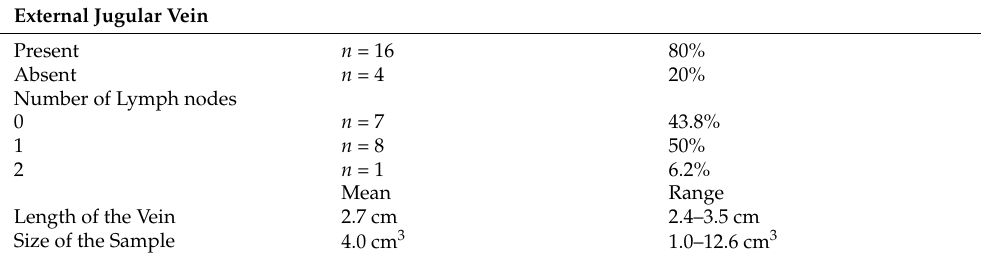
Table 2. Evaluation of specimens.